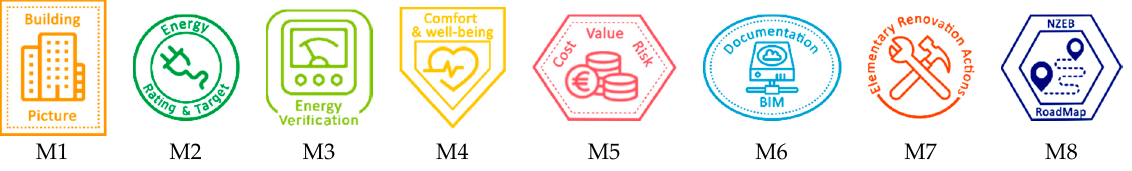
Figure 1. Identification of each ALDREN BRP module (M) with a specific passport stamp.